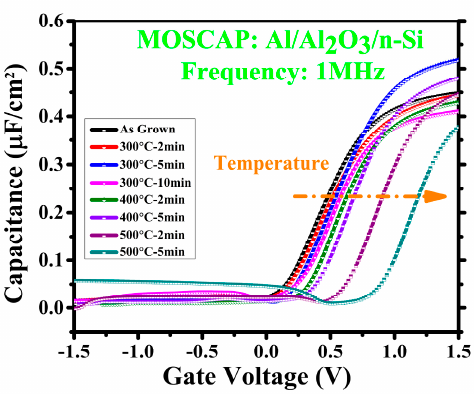
Figure 1. Capacitance–voltage curves comparison at 1 MHz.